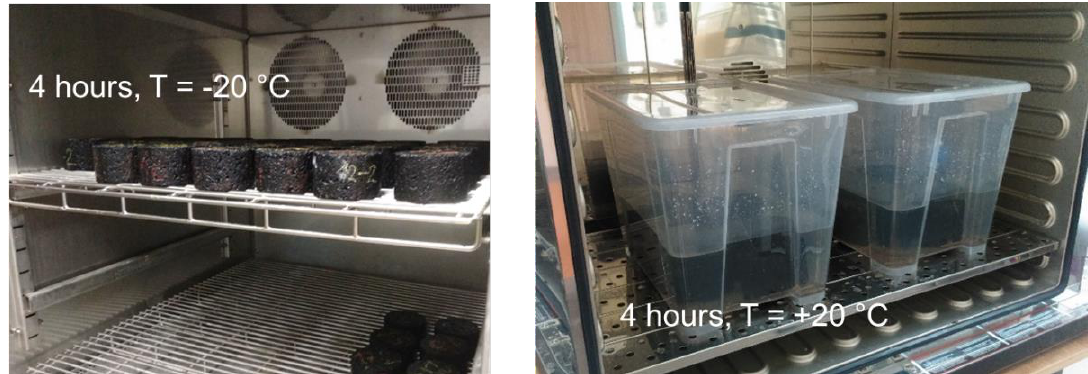
Figure 1. Samples in distilled water before freeze – thaw cycles (Photo: Authors).